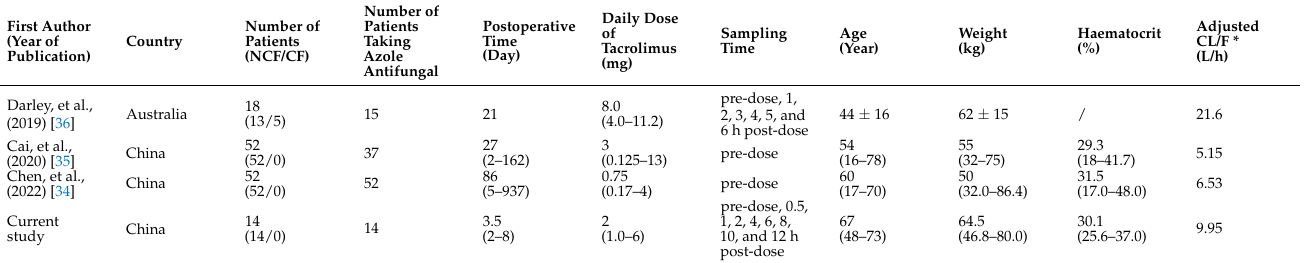
Table 4. Comparison of pharmacokinetics characteristics and patients’ demographics among different